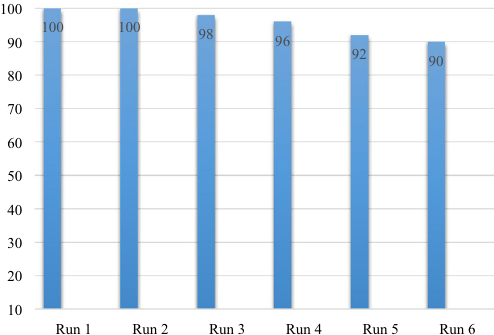
Figure 6. Reusability test of the HS-Alginate-Ag/Fe 3 O 4 for model